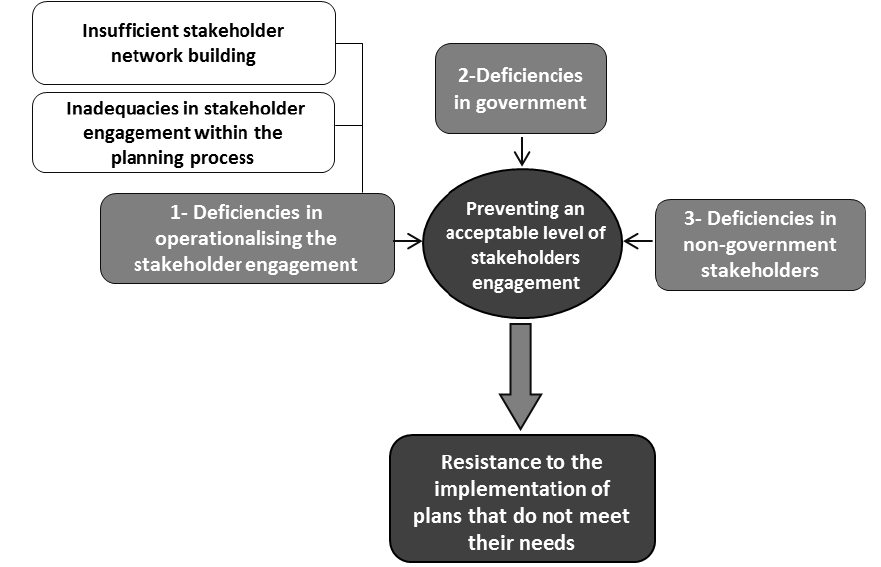
Figure 2. The conceptual framework. Source: The authors.